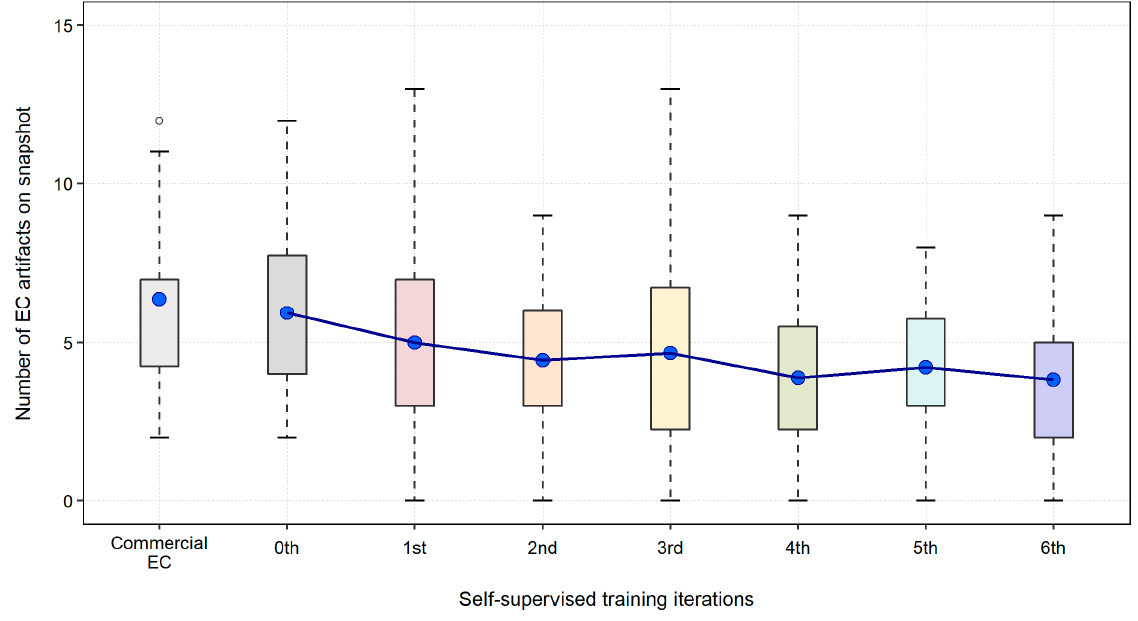
Figure 4. Comparison of the mean numbers of EC artifacts (indicated by blue circles) observed on